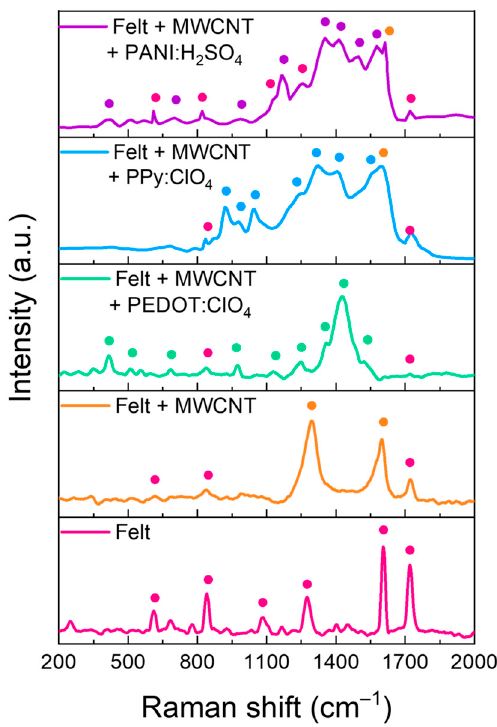
Figure 6. Raman spectra of felt fabric coated with MWCNTs and after polymers electrodeposition.